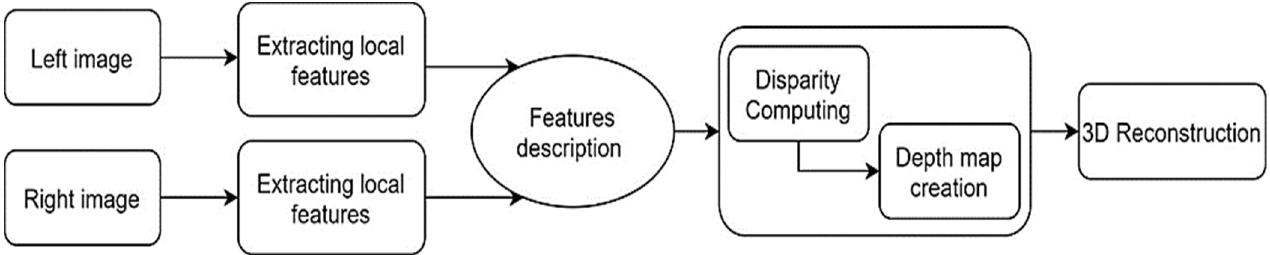
Figure 2. Pipeline of 3D reconstruction of tilled soil surface.